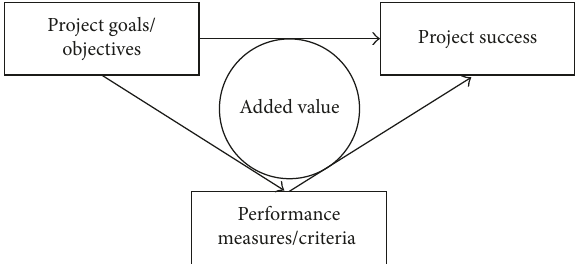
Figure 4: Relationship between the added value and related